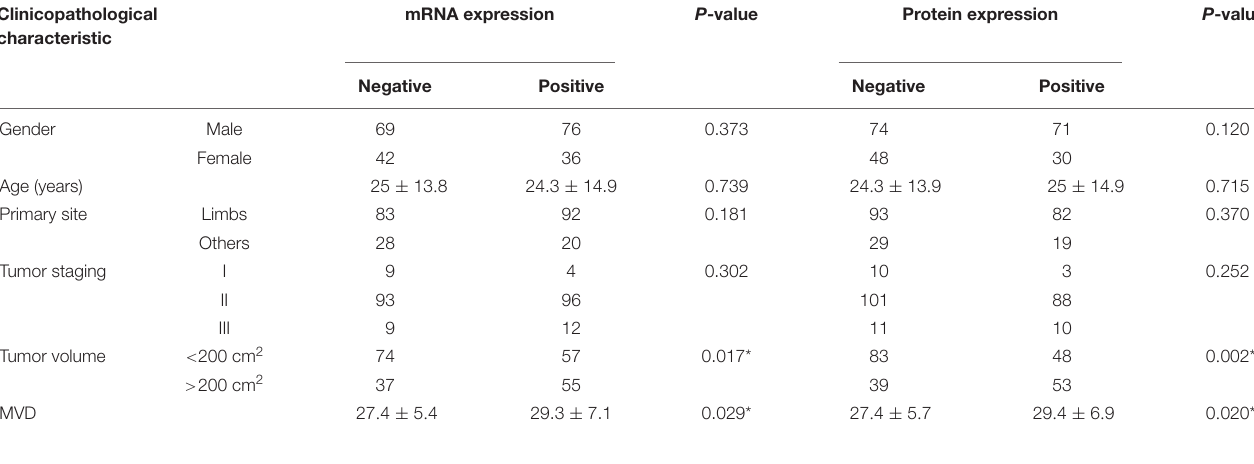
TABLE 2 | The relationship between MACC1 expression and clinicopathological characteristics. Clinicopathological